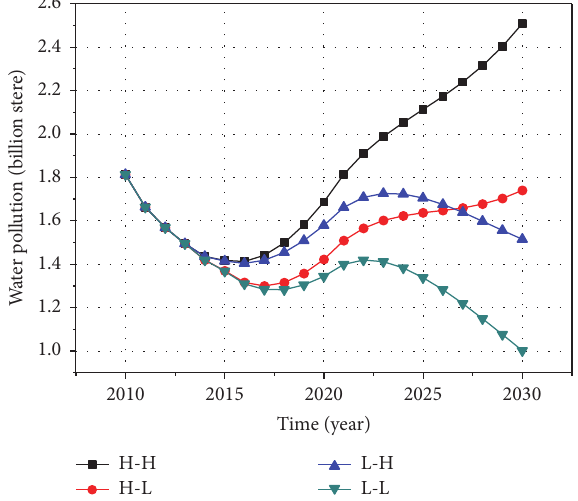
Figure 13: Water pollution under different development